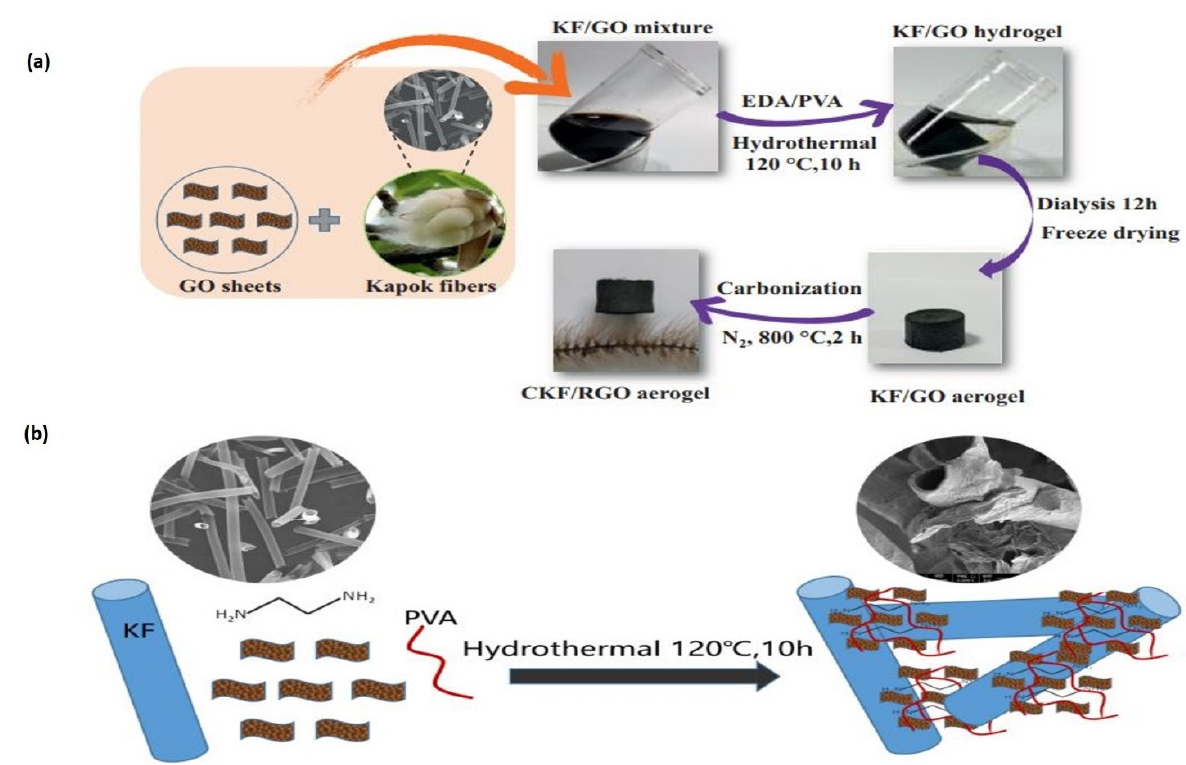
Figure 18. ( a ) An experimental flow diagram for preparing a CKF/RGO aerogel. ( b ) The KF/GO aerogel production mechanism. Reprinted with permission from Ref. [145]. Copyright 2020, copyright John Wiley and Sons.